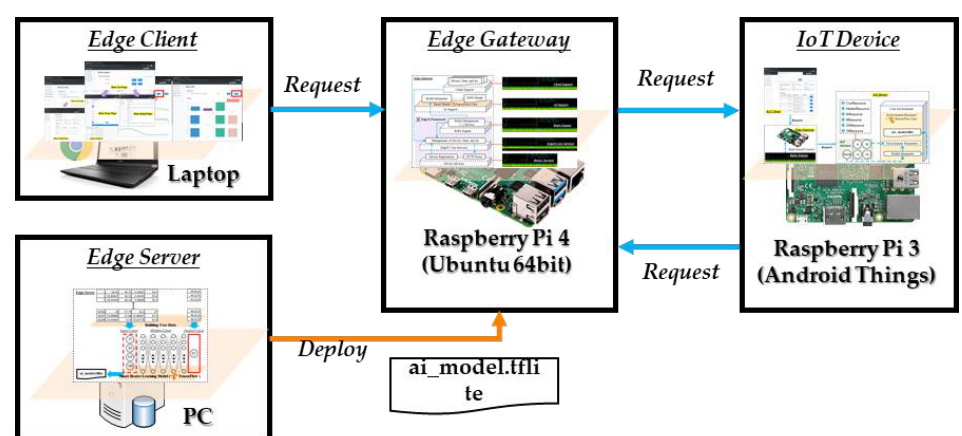
Figure 7. Implemented entities of the proposed embedded edge computing.